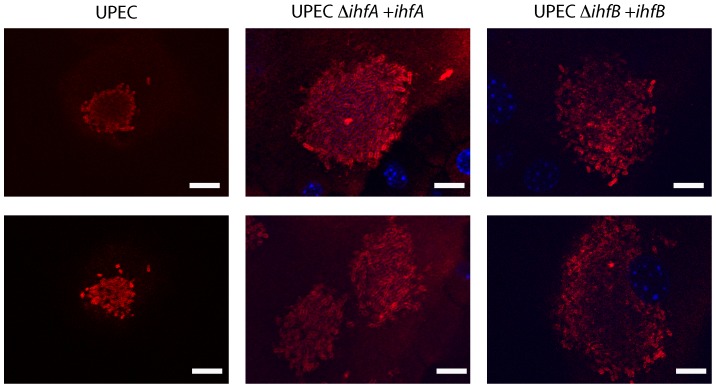
Community architecture is restored upon complementation in trans.Female mice were infected with UTI89, ROL745/ pHNá (UTI89 ihfA11), or ROL603/ pHNâ (UTI89 ΔihfB) for 6 hours. Bladders were prepared for visualization by immune-fluorescent microscopy [41]. Images were taken as an optical section. The strains are indicated above each panel. Scale bar  = 10 µm and scale is unchanged between images.